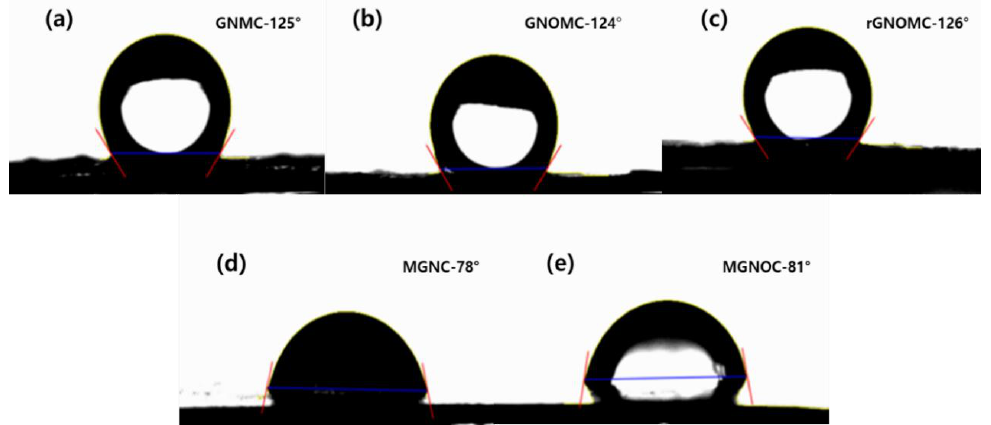
Figure 5. Contact angles of ( a ) GNMC, ( b ) GNOMC, ( c ) rGNOMC, ( d ) MGNC, and ( e ) MGNOC.